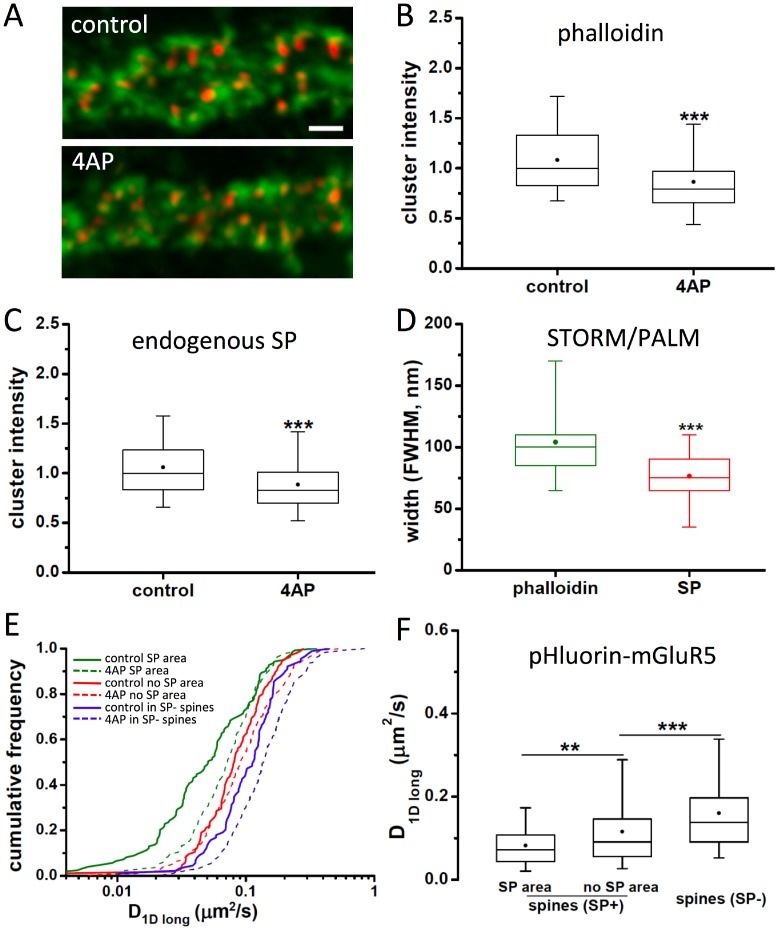
Effect of neuronal activity on SP distribution and mGluR5 diffusion.(A) Immunocytochemistry of endogenous SP (red) and A647-phalloidin staining (green) in hippocampal neurons under control conditions (top panel) or after 30 minutes of 50 μM 4AP incubation (bottom). Scale bar: 2 μm. (B,C) Normalised total fluorescence intensity of phalloidin (B) and SP levels (C) in control and 4AP treatment, quantified within SP-positive clusters (Table B in S1 File). (D) Measurements of rendered super-resolution images show no change in the widths of the SP and phalloidin domains in the spine neck after 4AP application (4AP: n = 30 spines, 7 cultures) compared to control (see Fig 2D, Table C in S1 File). (E) Cumulative distribution of pHluorin-mGluR5 diffusion coefficients tracked in SP- (blue) and in SP+ spines, either on top (green) or outside of SP clusters (red), in control (solid lines) and after 4AP treatment (dashed lines). (F) Diffusion coefficients of pHluorin-mGluR5 in SP- and SP+ spine necks after 4AP incubation (n ≥ 135 trajectories from 3–5 cultures; Table E in S1 File).